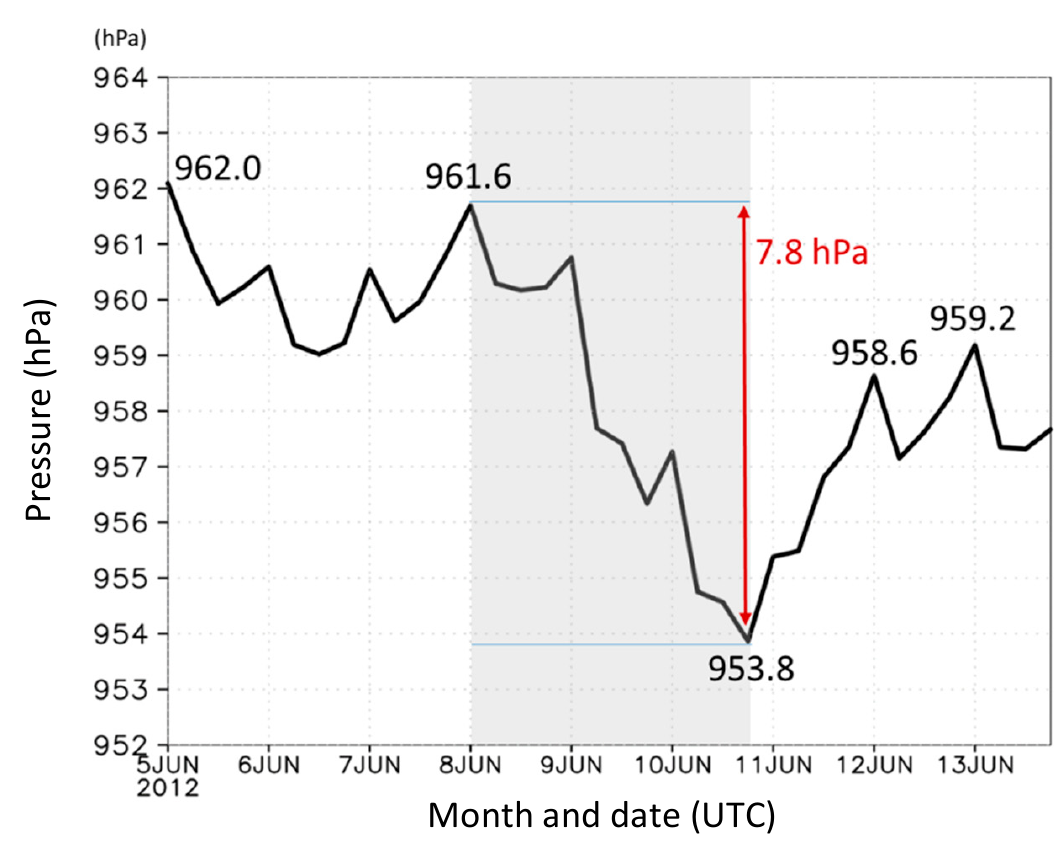
Figure 4. The time series of surface pressure (hPa) in ERA-Interim data, averaged inside the red box in Figure 1, in South China from 0000 UTC 5 to 1800 UTC 13 June 2012. The shading in gray indicates the period of most significant pressure fall (by 7.8 hPa in 66 h, from 0000 UTC 8 to 1800 UTC 10 June).